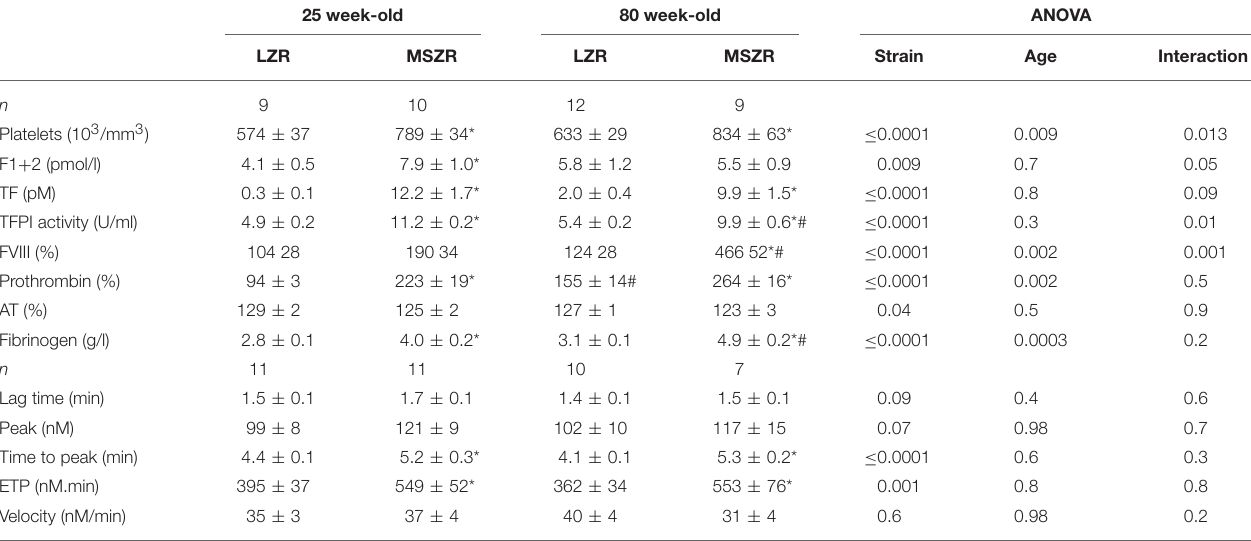
TABLE 1 | Blood coagulation parameters and thrombin generation parameters of LZR and MSZR at 25 and 80 weeks of